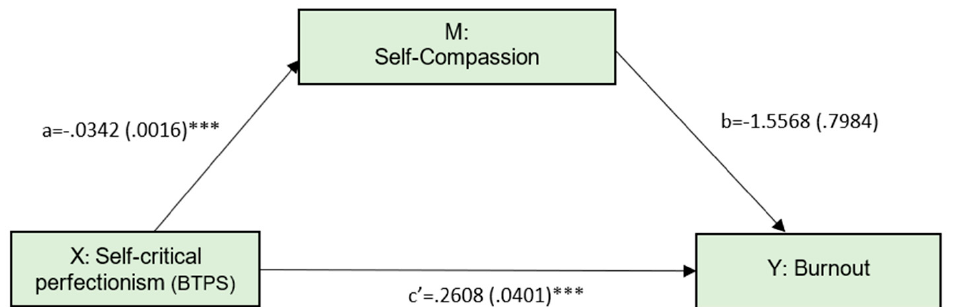
Figure 1. Simple mediation model, with self-critical perfectionism as the predictor. Gender was controlled and did not present a significant effect. Numbers represent unstandardized coefficients.